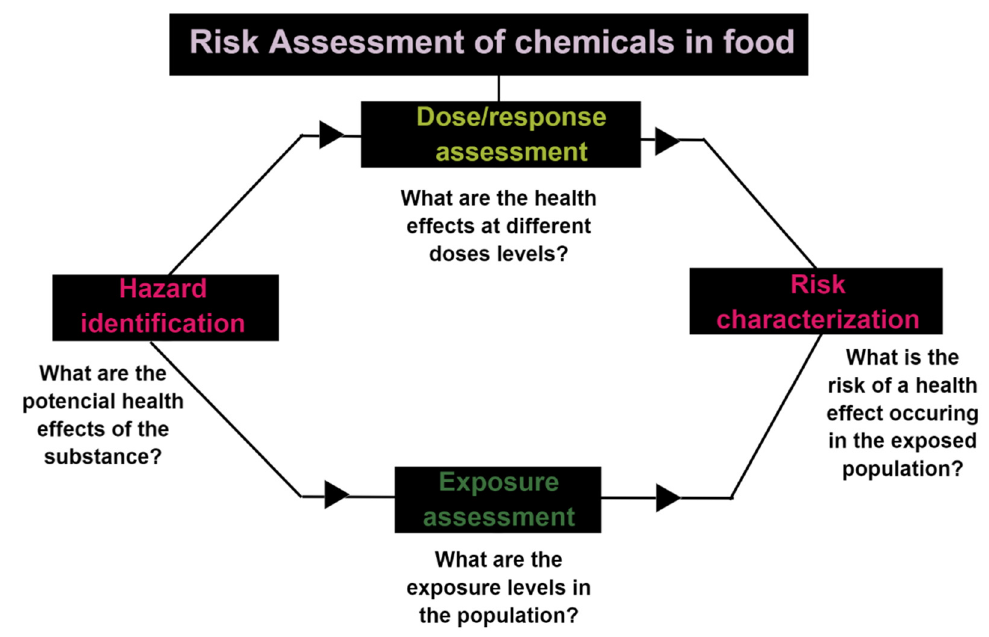
Figure 7. The regular approach to perform a specific risk assessment of chemicals in food (adapted from Pieke et al.